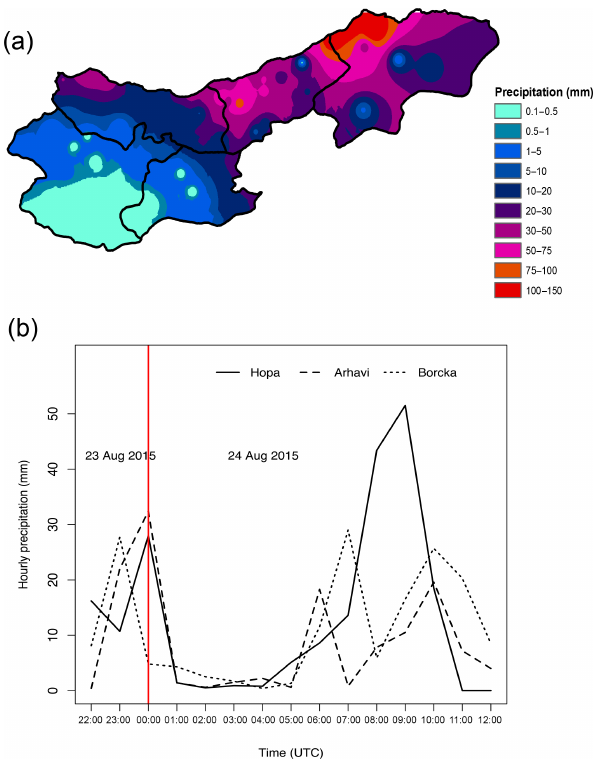
Figure 4. (a) Total daily precipitation in the eastern Black Sea (00:00–24:00UTC), 24 August 2015. The map is based on data from the same meteorological stations represented in Fig. 1 (station names are listed in Table 1). (b) Hourly evolution of the 24 Au- gust 2015 rainstorm in Artvin at three selected stations representing flash-flood